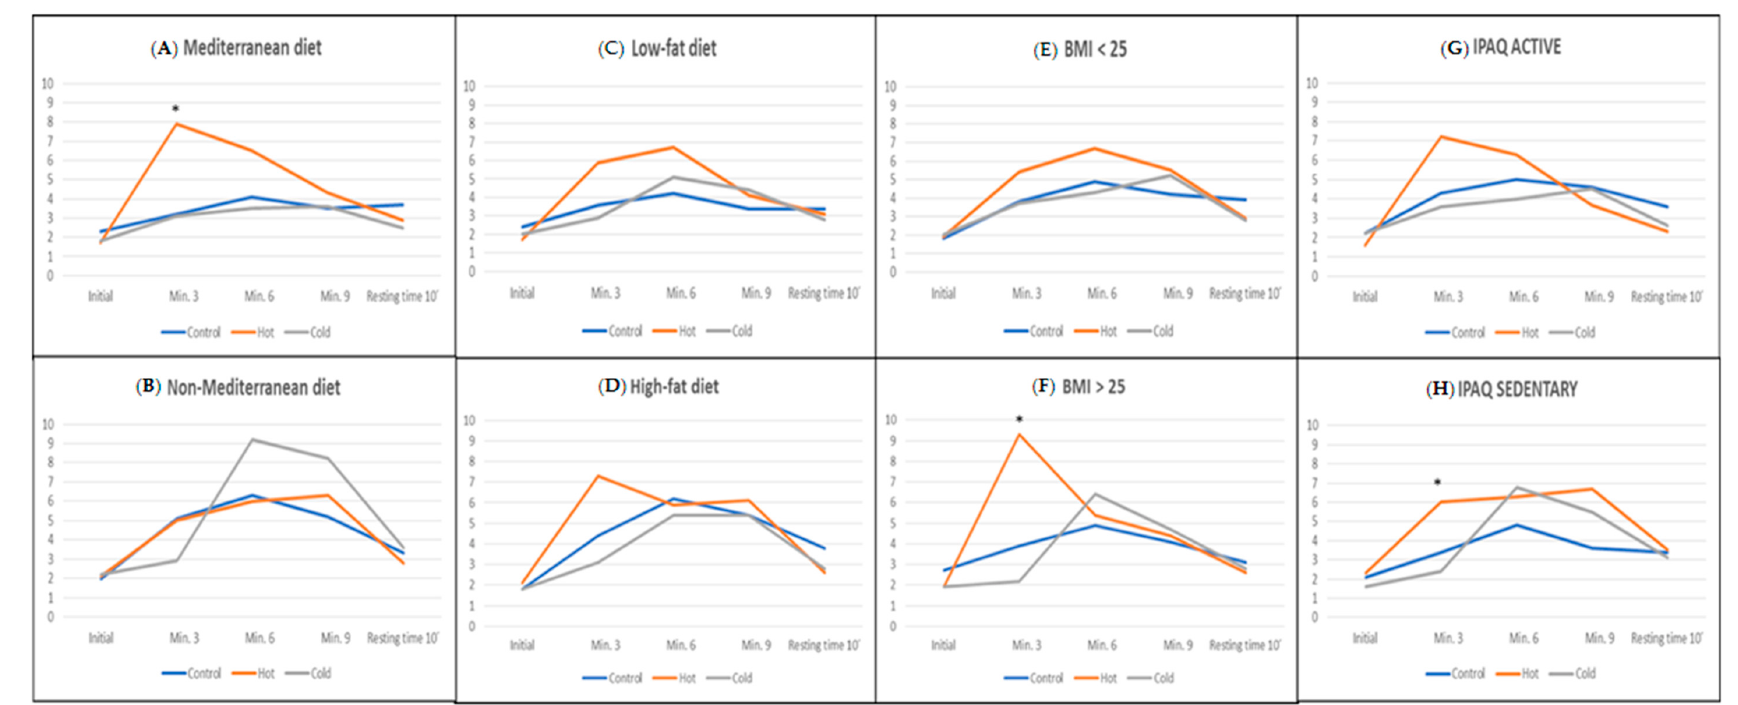
Figure 2. Blood lactate during the test and after 10 min of resting time, considering the environmental conditions and according to the dietary habits and lifestyle of the participants, as follows: ( A ) Mediterranean diet, ( B ) non-Mediterranean diet, ( C ) low-fat diet, ( D ) high-fat diet, ( E ) BMI < 25, ( F ) BMI > 25, ( G ) IPAQ active, ( H ) IPAQ sedentary. * Statistically significant differences. Mediterranean diet Min. 3 ( p = 0.006), BMI > 25 Min. 3 ( p = 0.008), IPAQ sedentary Min. 3 ( p = 0.035).